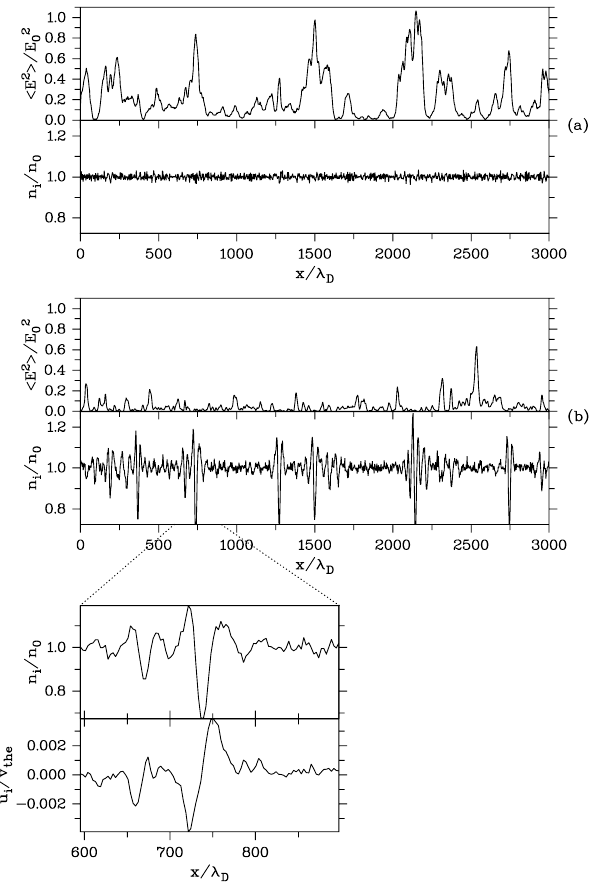
Figure 4. Spatial profiles of field energy and proton density at times t = 300 ω − 1 pe (a) and t = 800 ω − 1 pe (b) , illustrating the formation and relaxation of spiky field events and the associated proton response. Bottom panels: spatial variation of proton density and bulk velocity of the ion acoustic pulse at x/λ D ≈ 750 in better resolution. Param- eters as in Fig. 1.